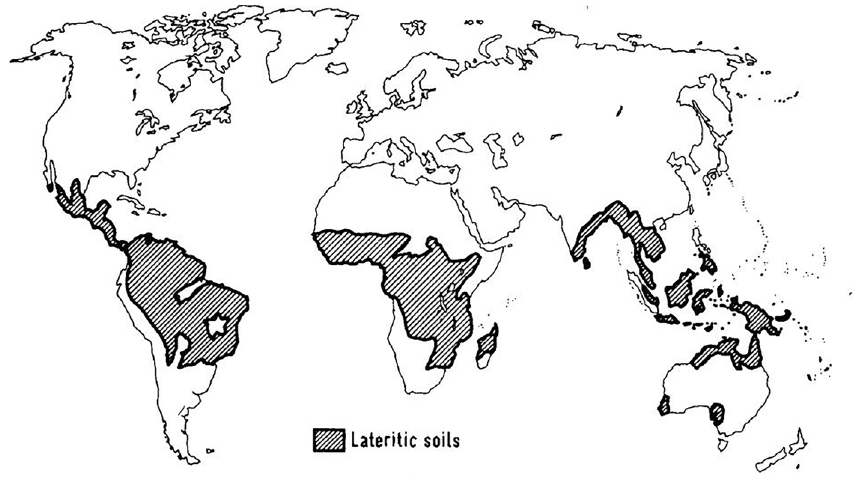
Figure 2. Regions with the occurrence of lateritic soils (Charman 23 ).